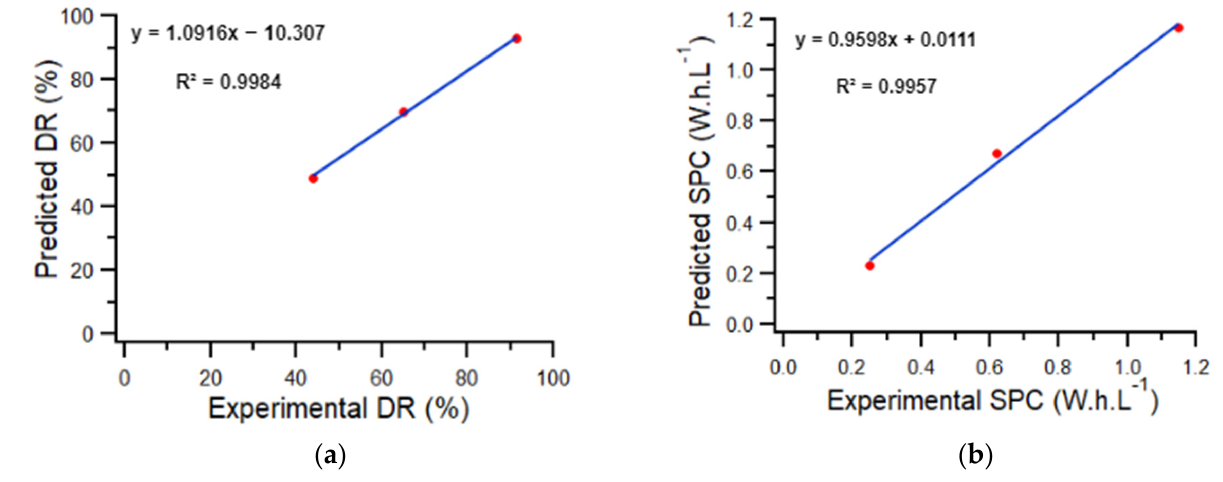
Figure 5. ( a ) Predicted values of the responses DR (%); ( b ) SPC (Wh·L − 1 ) versus experimental values. The graphs show a good agreement between the experimental and the predicted